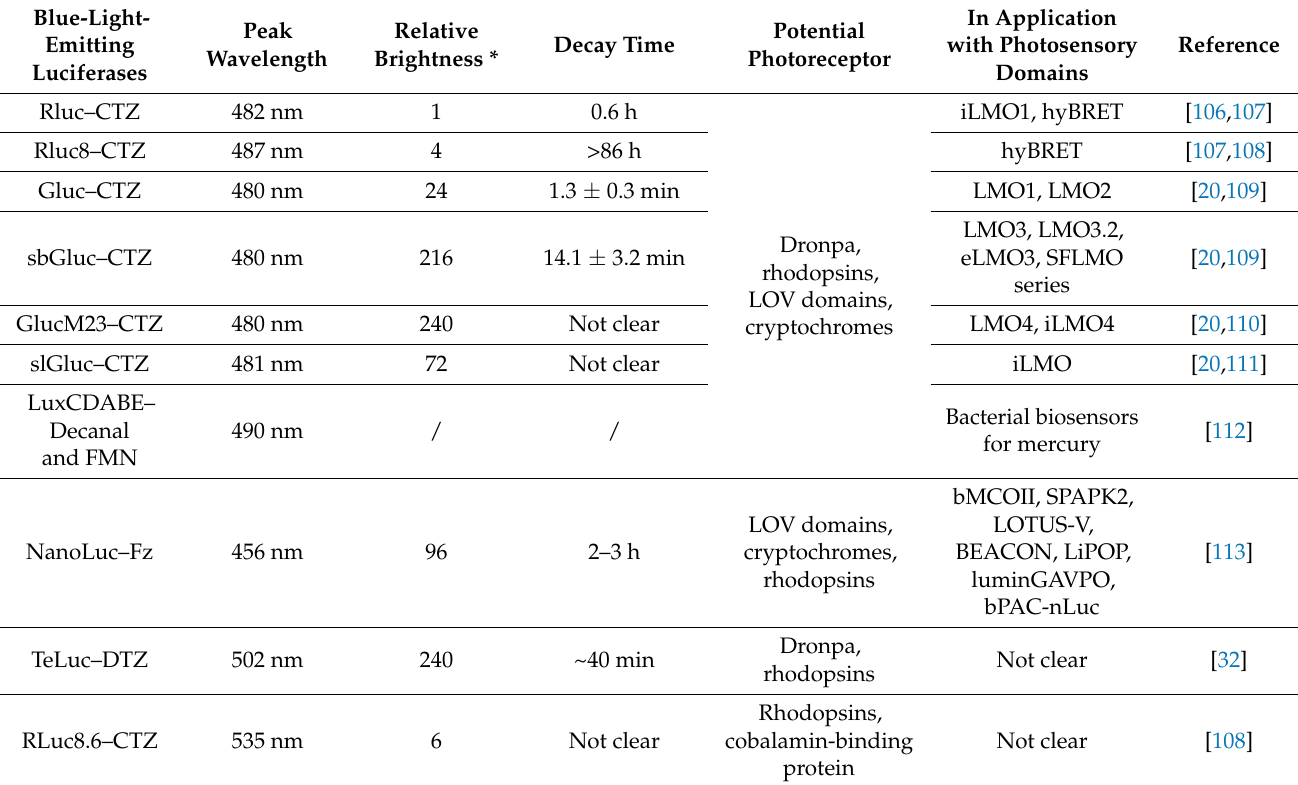
Table 2. The comparison of classic blue-light-emitting